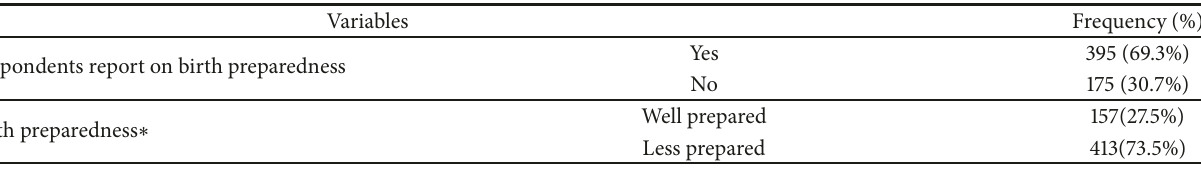
Table 4: Level of birth preparedness from a study conducted among women who gave birth recently in Jardega Jarte district Oromia Region, western Ethiopia, from January 1 to February 2,